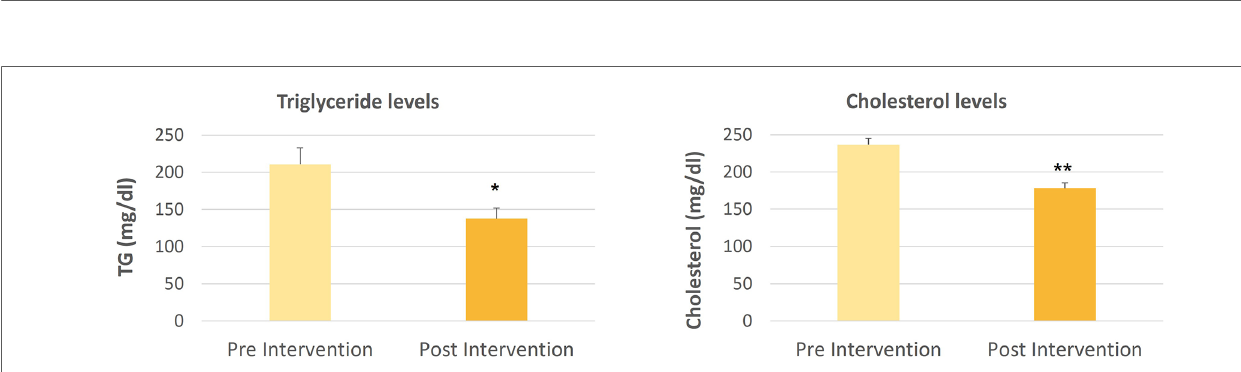
FIGURE 1 Triglyceride and cholesterol levels comparison in cricket players ( n =10) between pre and post-intervention period of 21 days supplementation with Spirulina and Khejri in combination, * p <0.05, ** p <0.01, *** p <0.001.